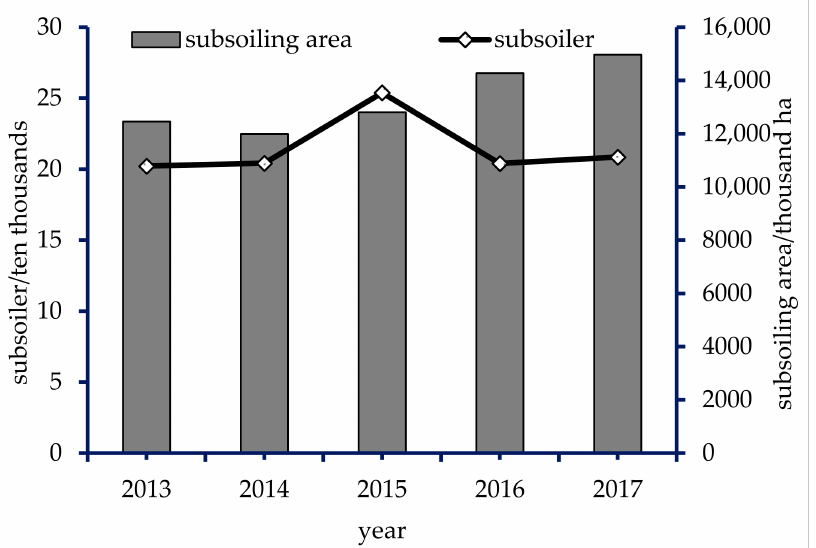
Figure 1. Diagrams of changes of subsoiler ownership and subsoiling area from 2013 to 2017. (Interpretation of national agricultural mechanization statistics annual report in 2013–2017).